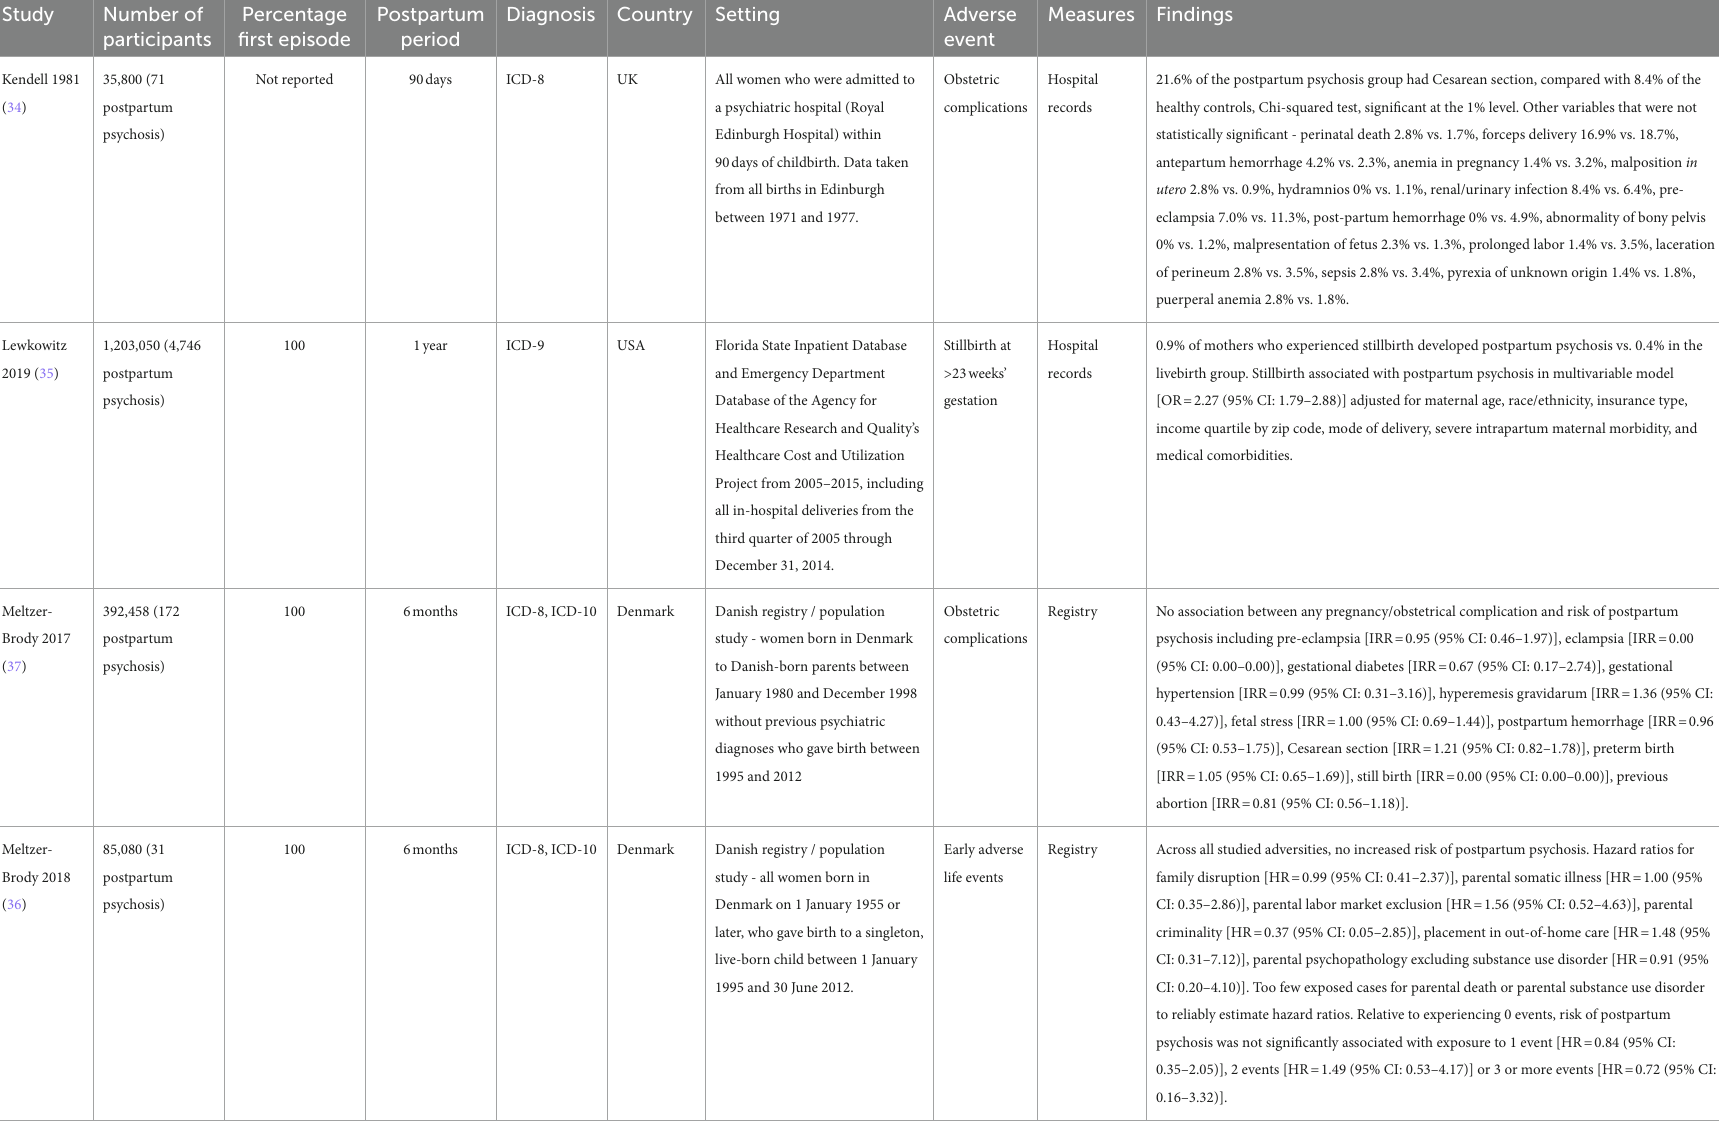
TABLE 2 Summary of cohort studies examining onset of postpartum